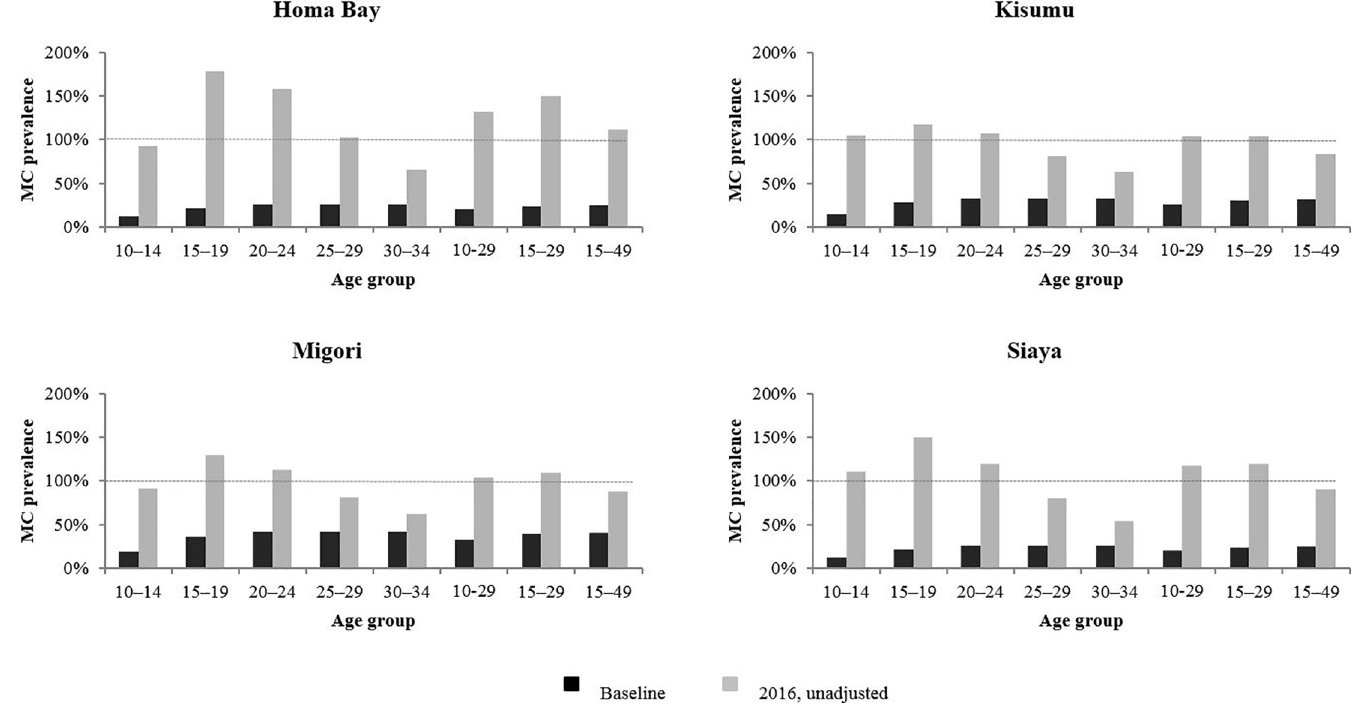
Fig 1. Male circumcision (MC) prevalence before start of voluntary medical male circumcision (VMMC) program and unadjusted modeled MC prevalence by end 2016 for Homa Bay, Kisumu, Migori, and Siaya. Black bars represent age specific MC prevalence before the start of the VMMC program. Light grey bars represent modeled age specific MC prevalence by end 2016. Dashed horizontal line denotes MC prevalence of